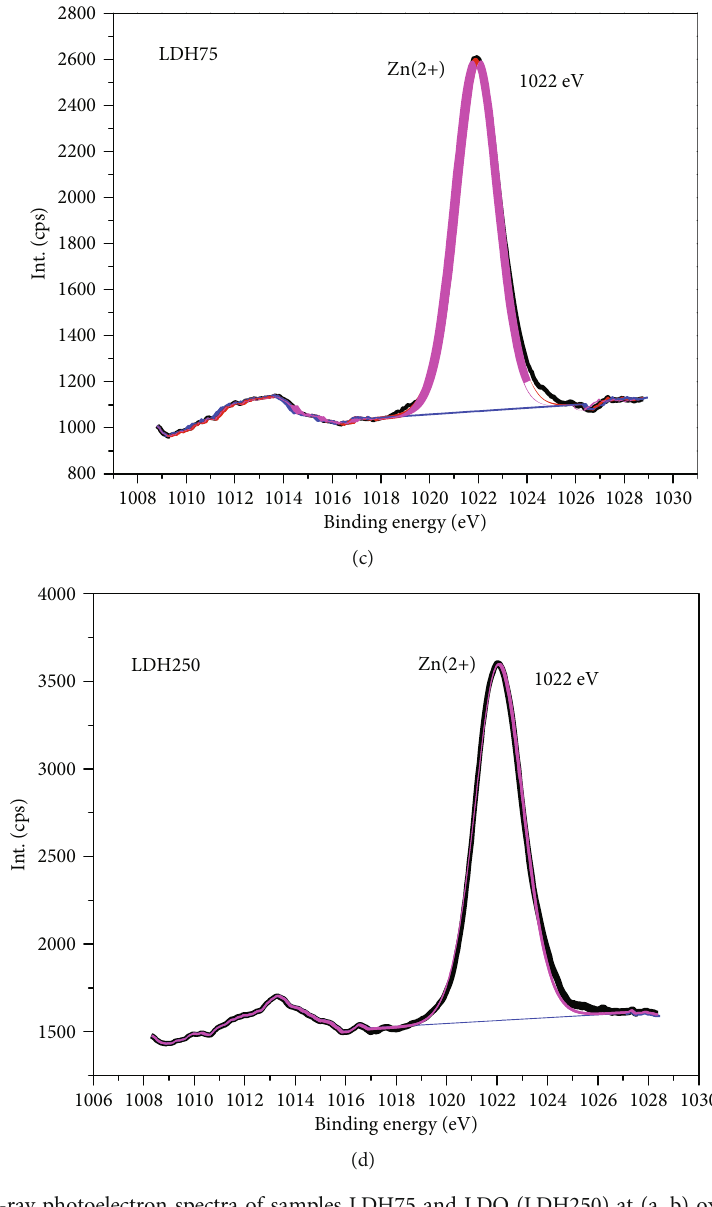
Figure 3: High-resolution X-ray photoelectron spectra of samples LDH75 and LDO (LDH250) at (a, b) oxygen (1s) and (c, d) zinc (2p) binding energies. The top and bottom rows represent before and after annealing,